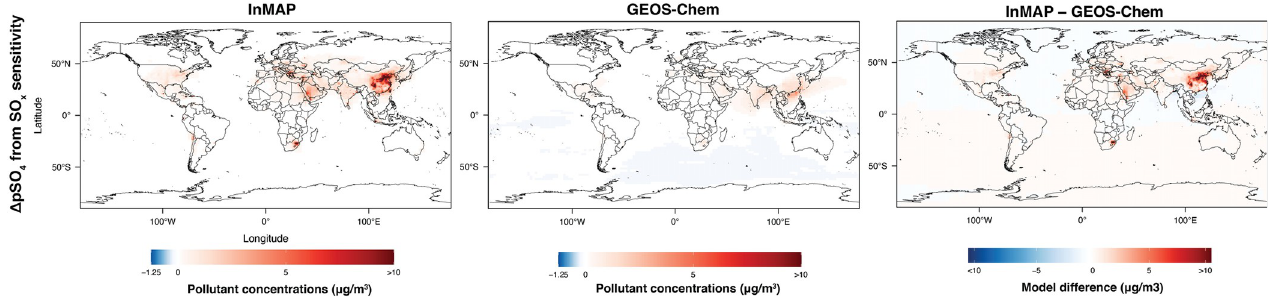
Fig 12. Comparison between Global InMAP and GEOS-Chem for predicting changes in pSO 4 concentrations from a 100% increase in SO x emissions from power generation.